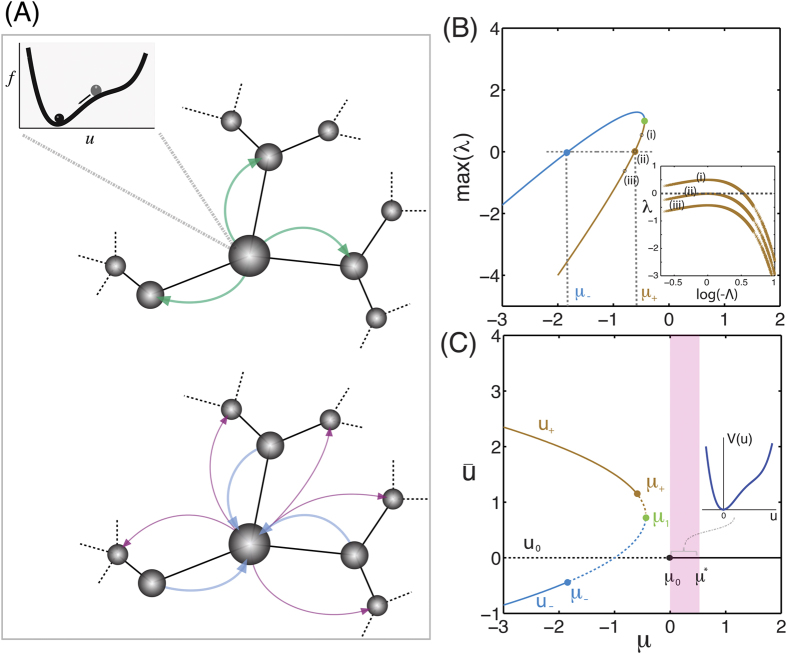
(A) Pictorial illustration of our dynamical model of network interactions. Locally, the nodal activation state is driven by the dynamic forcing term f (u, μ). In the inset we show the potential landscape—minus the integral of f with respect to u, which exhibits a single well (at u = 0) with an inflection point, a necessary condition for localized patterns to exist. Nodes interact in the network through diffusion-like exchanges via the links connecting them. The network Laplacian operator, L(2), represents short range diffusion of the species in the system (top). The network bi-Laplacian operator, L(4), induces short range anti-correlation with the nearest-neighbors, and long-range correlation with the second-nearest neighbors (bottom). (B,C) Linear stability analysis of the flat stationary solutions of our model. (B) The maximum value of the growth rate λ as a function of the bifurcation parameter μ for the two flat stationary states u+ (brown) and u− (blue) on a Barabási-Albert network model with mean degree  and size N = 2000. When the maximum value of λ is negative, the state is stable with respect to small non uniform perturbation. (Inset) The growth rate λ as a function of the Laplacian eigenvalue Λ (Eq. (5)) for three different values of the bifurcation parameter μ as indicated in the main diagram for the flat stationary solution u−. (C) The flat stationary solutions u0 and u± as a function of μ on the same network. Solid (dotted) lines represent stability (instability) with respect to small non-uniform perturbations. The labelled bifurcation points are μ0 = 0, μ1 = −0.44 and μ+ = −0.62 and μ− = −1.82. The pink shaded region is where we observe localized self-organization patterns with respect to the trivial solution u0. For values of μ outside that region we get either global activation patterns (for μ < μ0) or any perturbation relaxes back to the flat stationary solution (for μ > μ*).